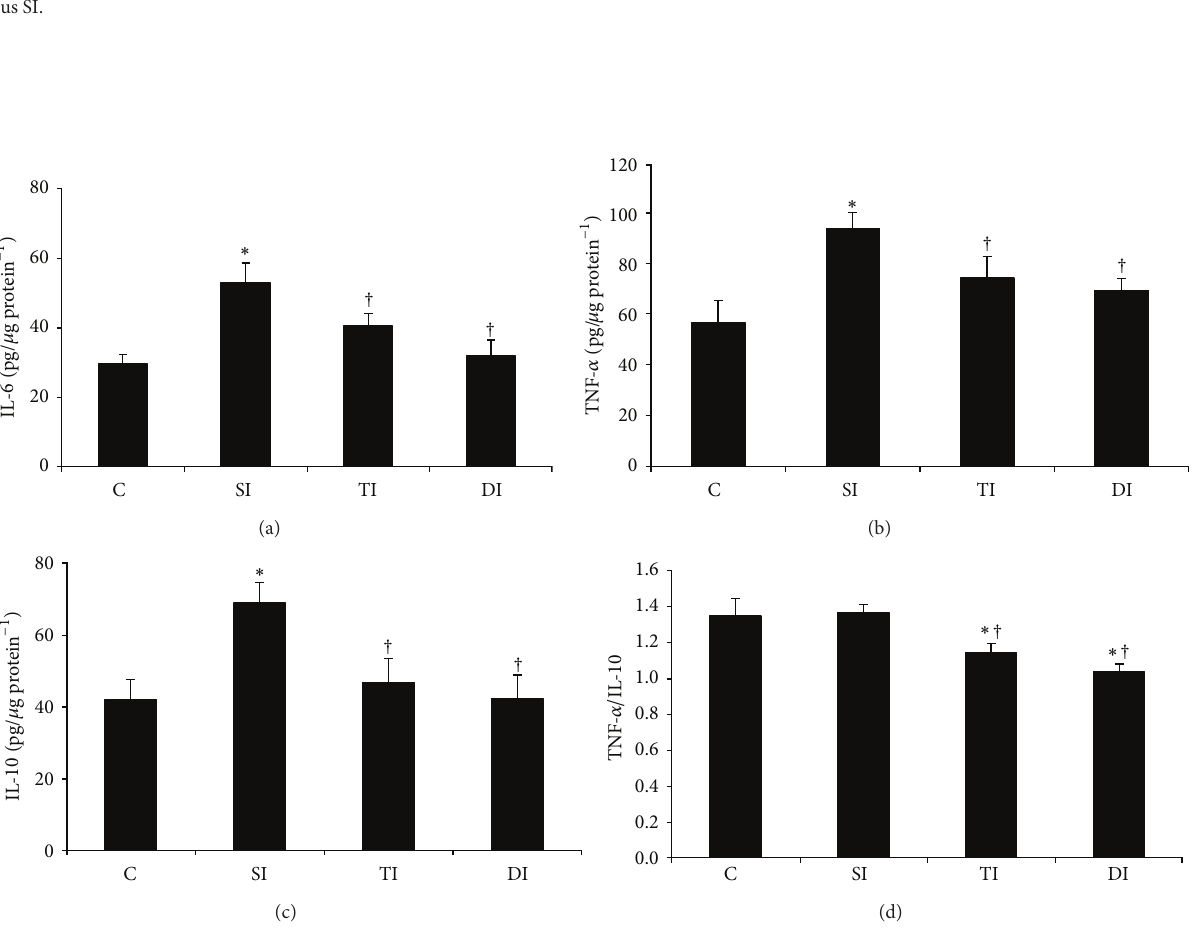
Values are expressed as mean ± SEM. SAP: systolic arterial pressure; DAP: diastolic arterial pressure; MAP: mean arterial pressure; HR: heart rate; Var PI: variance of pulse interval; LF: low frequency band; HF: high frequency band; Var SAP: variance of systolic arterial pressure. ∗ 𝑃 < 0.05 versus C; † 𝑃 < 0.05 versus SI.